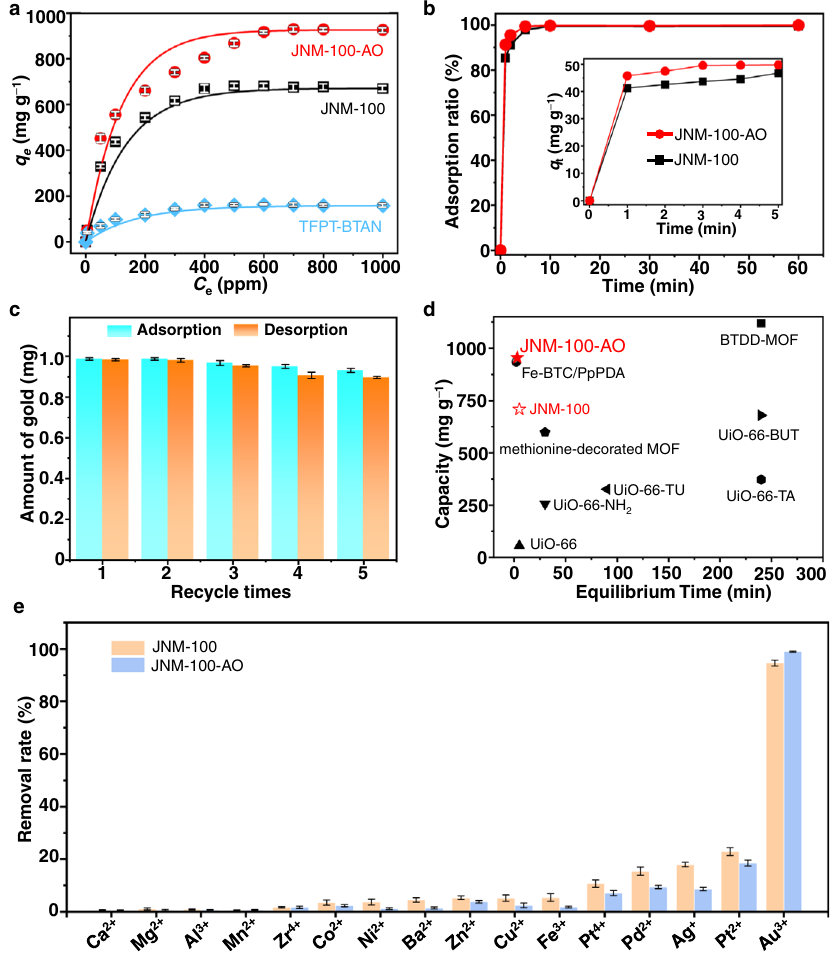
Fig. 4 | Selective gold adsorption and extraction using JNMs. a Adsorption iso- therms of gold at the initial concentration range of 5 – 1000ppm at rt using JNM- 100-AO, JNM-100, and TFPT-BTAN, suggesting superior af fi nity of JNM-100-AO toward gold ( C e represents the equilibrium concentration and q e represents the equilibrium adsorption capacity). b Kinetic studies of gold adsorption at an initial concentration of 50mgL − 1 for JNM-100 and JNM-100-AO, respectively (inset: expansionofthe fi rst5min,where q t representstheadsorptioncapacityatacertain time). c Recyclability test of JNM-100-AO for adsorption (cyan) and extraction